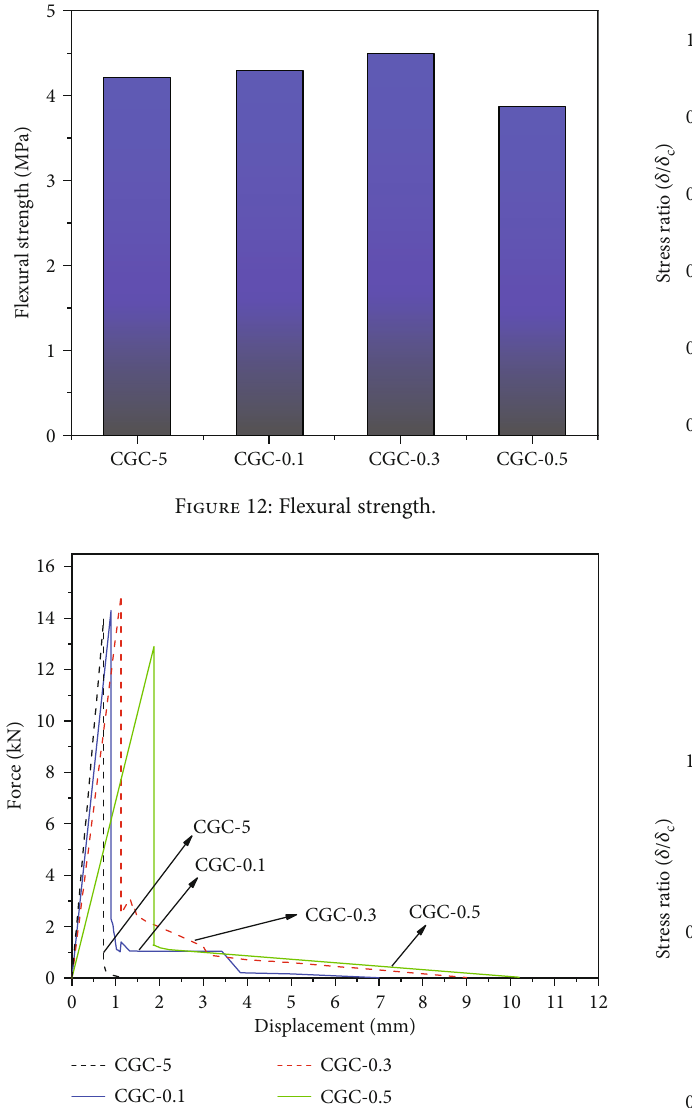
Figure 13: Pressure-displacement curve.